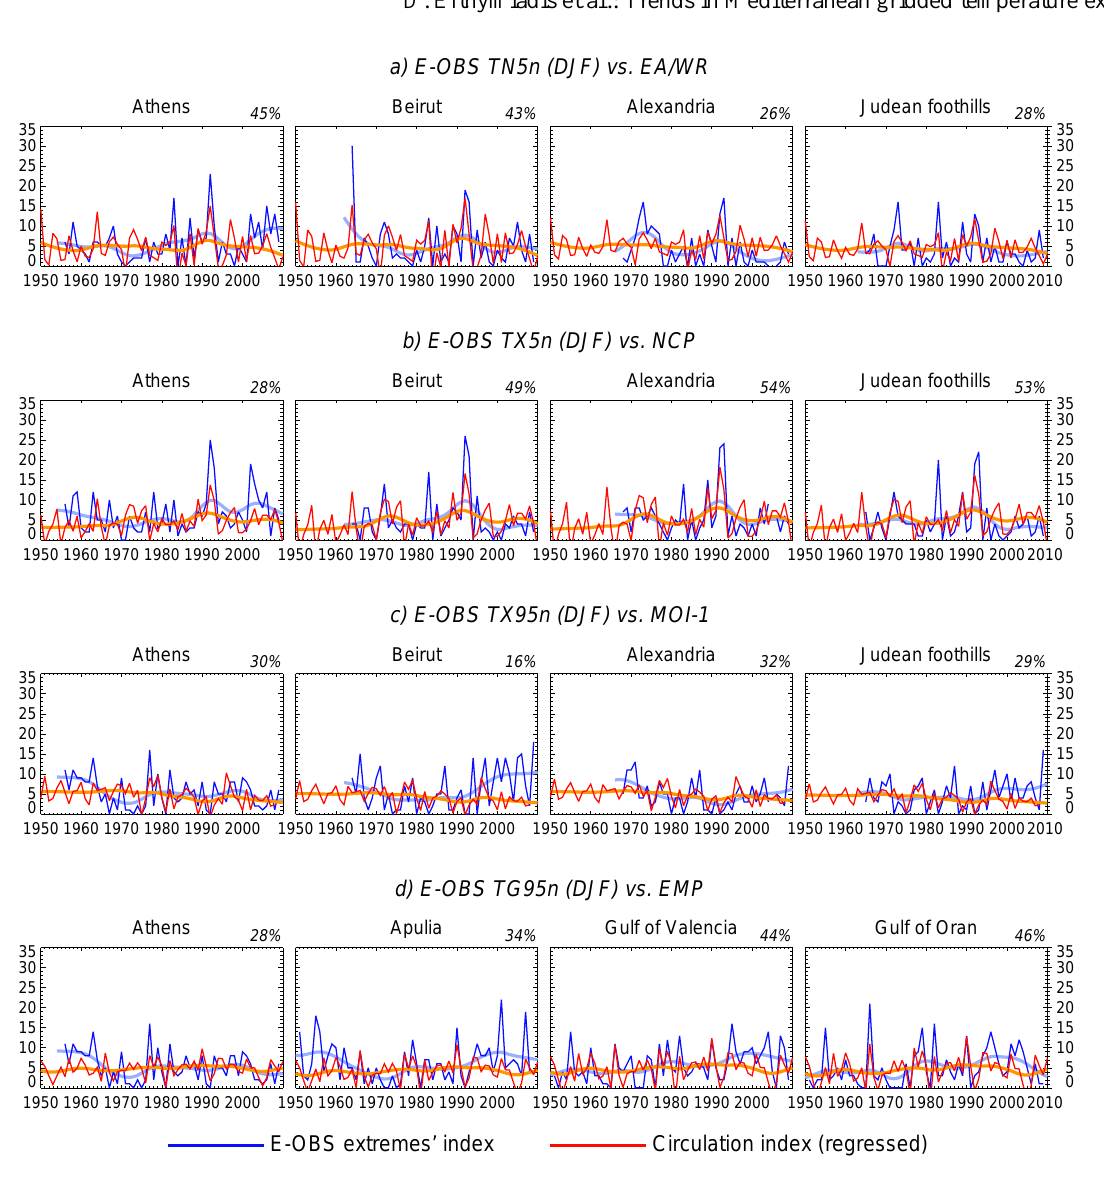
Fig. 6. Winter (DJF) indices of temperature extremes from E-OBS (in blue) for selected case-study domains plotted against reconstructed values (in red) from the atmospheric circulation index linear regressions: (a) TN5n vs. EA/WR, (b) TX5n vs. NCP, (c) TX95n vs. MOI-1, and (d) TG95n vs. EMP. The variance explained (%) by the circulation index is shown above each